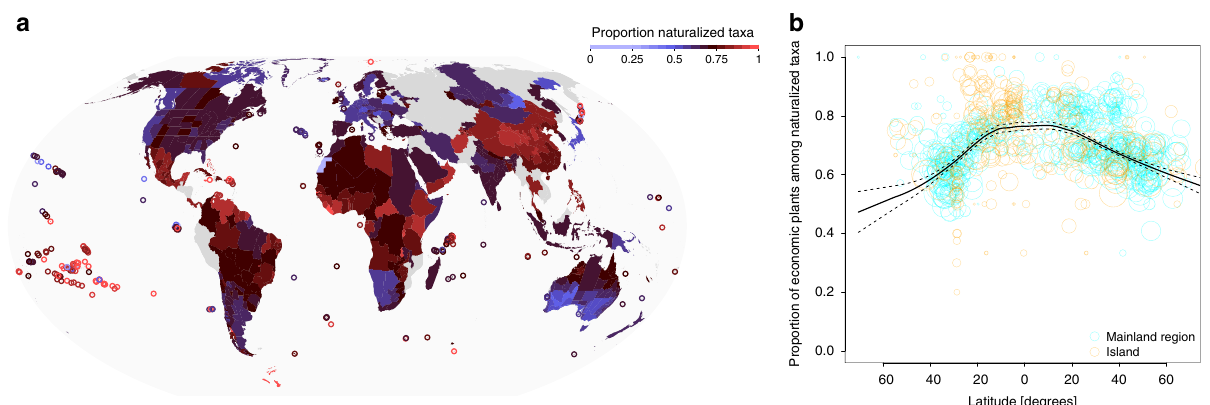
Fig. 7 The proportion of economic plants in regional naturalized alien fl oras. a Map of the world showing for each of the GloNAF regions the proportion of naturalized taxa that have an economic use. Circles were used to increase the visibility of small islands and island groups on the map. b Relationship between latitude and proportion of economic plants in regional naturalized fl oras. Cyan and orange circles correspond to mainland regions ( n = 542) and islands ( n = 319), respectively. The size of the circles is proportional to the natural logarithm of the number of naturalized alien plants in a region. The black solid line and the dashed lines are the fi tted LOESS smoother (with the default span = 0.5) and its 95% con fi dence interval from a generalized additive model (R package gam 66 ).